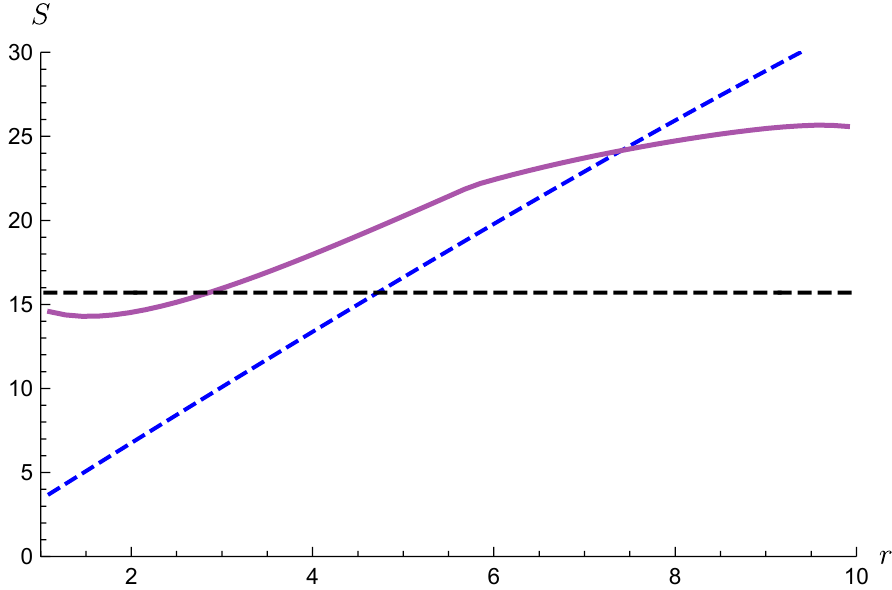
Figure 15 . A plot of various entropies computed using our extended Ryu-Takayanagi formula as the evaporation protocol proceeds. The entropies associated to the purple, individual dashed blue, and dashed black curves in (cid:12)gure 9 are shown here as the purple, dashed blue, and dashed black curves respectively. The dashed black line is the entropy of the real black hole horizon with r h = 10 and G N = 1. The minimum of the dashed blue line and dashed black line is the entropy of the radiation region R 1 [ R 2 . The entropy of region R 1 is the minimum of the dashed blue curve and purple curve. We have chosen ‘ = 1 and c=c 0 = 0 : 2, which determines G 0 and ‘ 0 . The dashed blue N line grows approximately linearly as the inception modulus r 0 is increased. The solid purple line h is the entropy of the minimal entropy infalling geodesic, including a possible contribution from the real black hole spacetime. The Page transition occurs when the dashed blue line crosses the dashed black line. The partial island becomes reconstructible from a single radiation leg after the purple line crosses the dashed blue